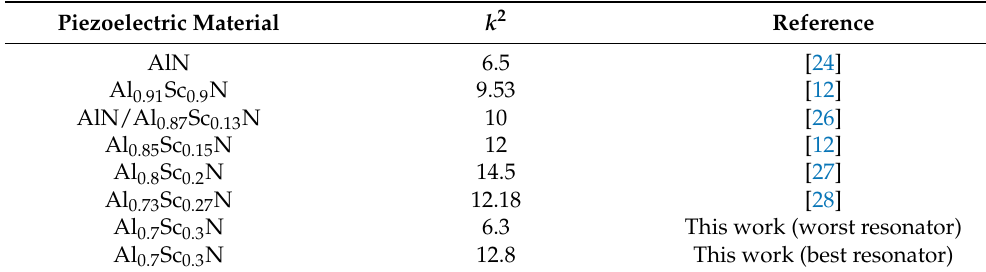
Figure 4. Radial distribution of mean k 2 values for Al 0.7 Sc 0.3 N ‐ based SMRs. The distance is measured from the sputtering chamber sample holder center. The error bars represent one standard deviation. Table 1. k 2 values of best and worst resonator presented in this work in comparison with state-of-the- art FBAR devices.